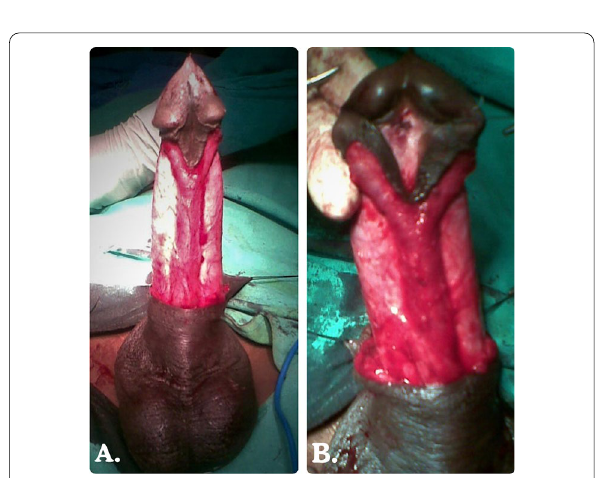
Fig. 2 A Intraoperative picture of a 15.4 years old with distal penile hypospadias showing well-developed robust spongiosum. B Intraoperative picture of a 13 years old with distal penile hypospadias showing well-developed robust